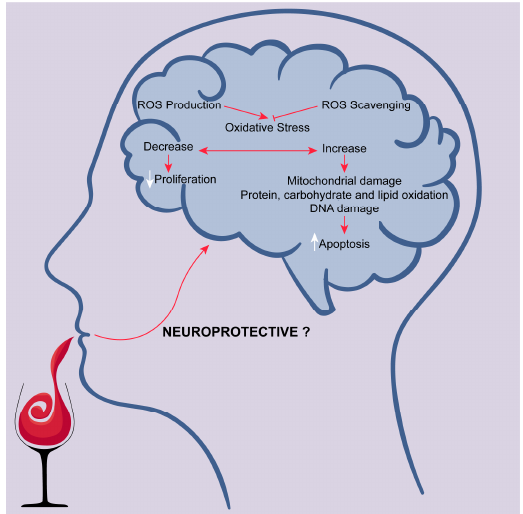
Figure 3. Oxidative stress in neurodegenerative diseases. ROS—reactive oxygen species.